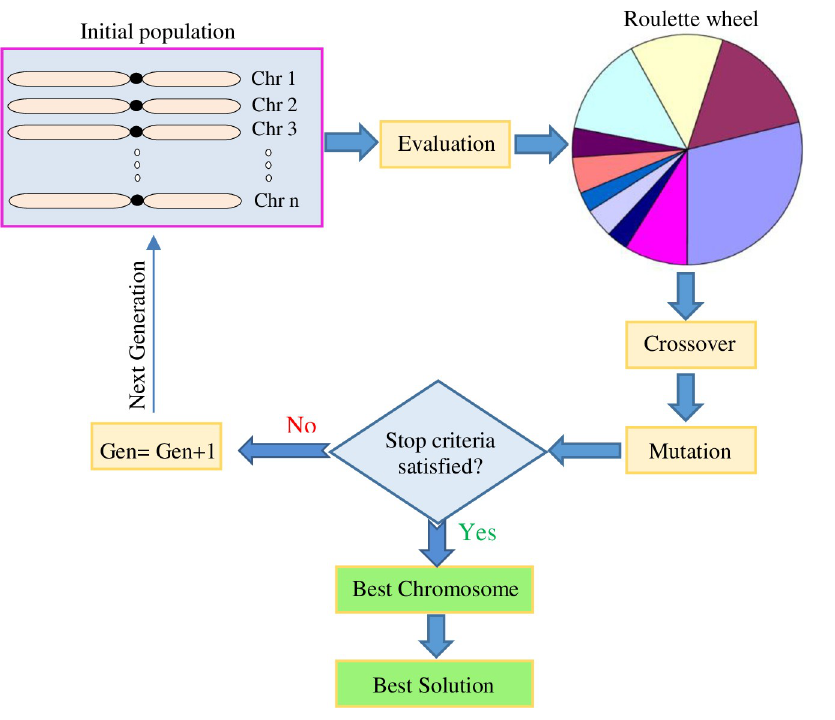
Fig 1. Schematic diagram of genetic algorithm.